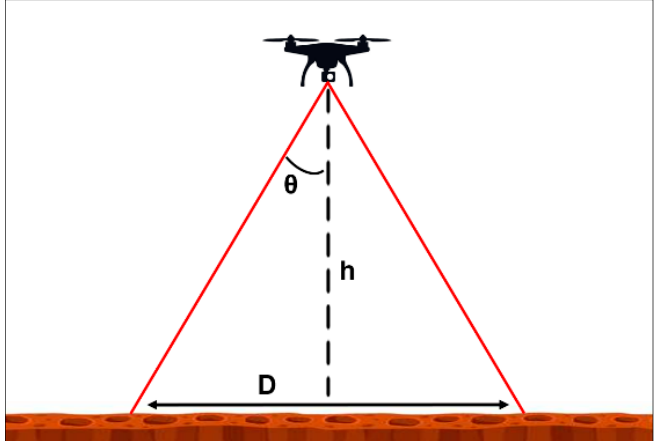
Figure A1. Diagram of the detector field of view while flying. A change in height ( h ) above the ground level will affect the spatial area that the instrument senses at the surface ( D ).